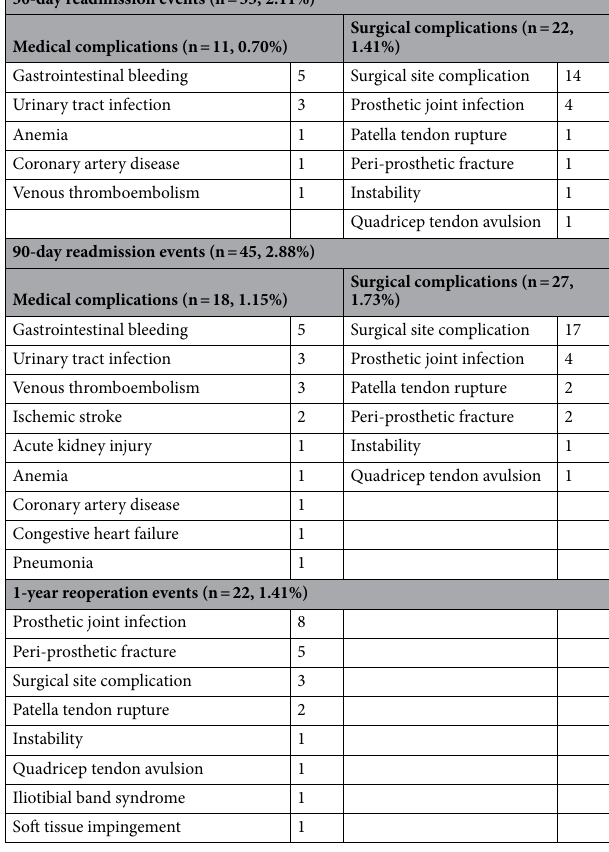
Table 2. Incidence of postoperative readmission and reoperation events.